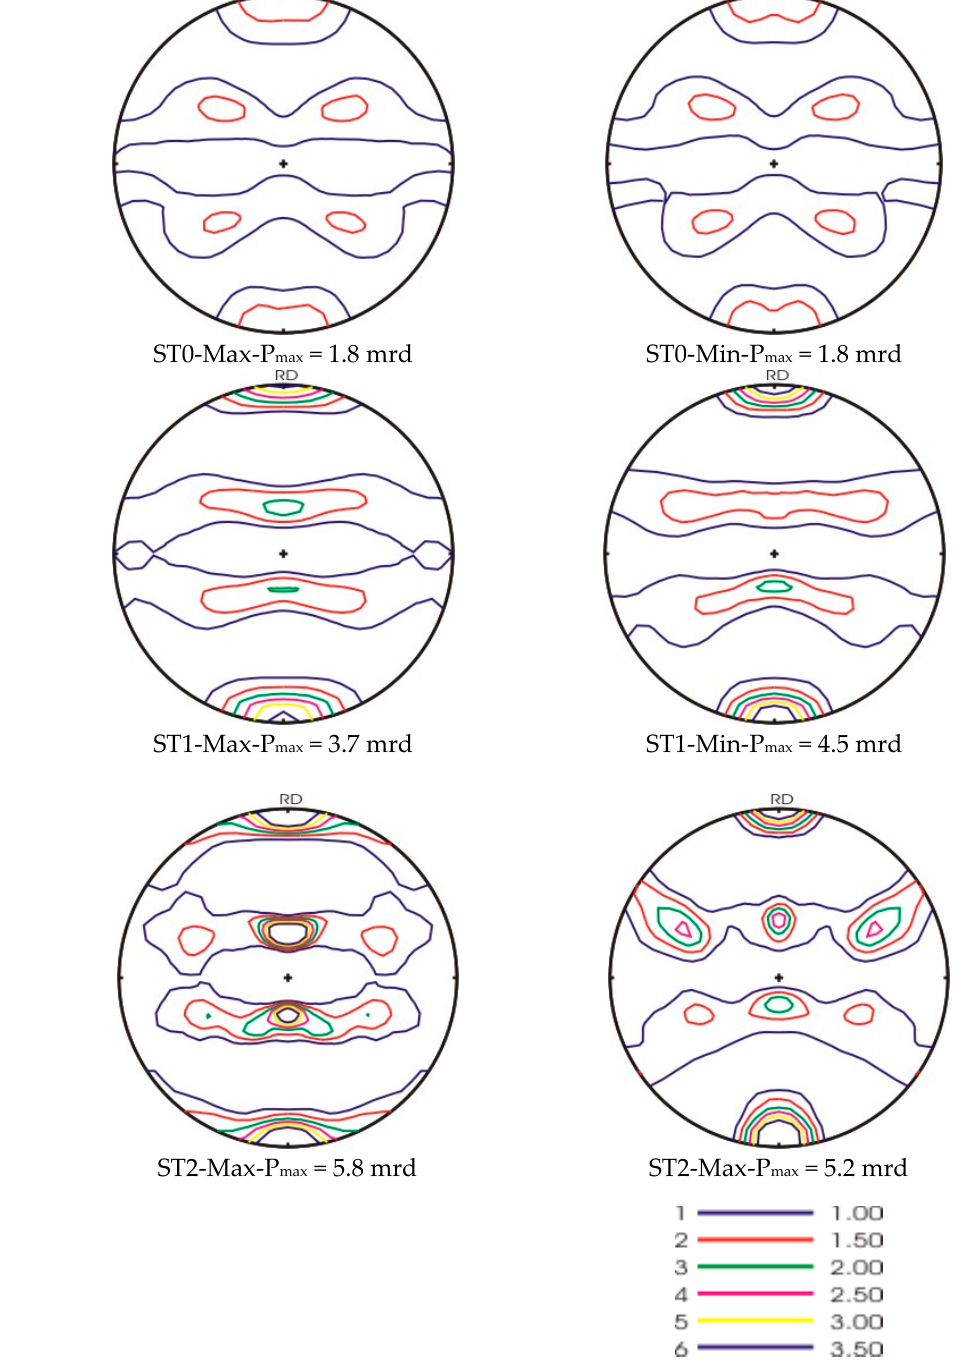
Figure 10. The (111) pole figures of tube 5ST after different passes.